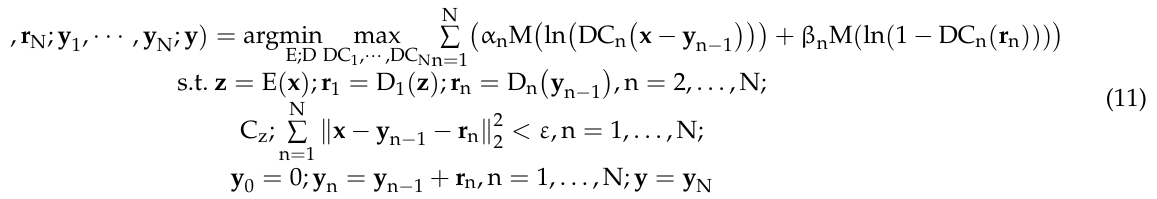
Figure 6. The architecture of residual-adversarial cascade decoders-based auto-encoders.